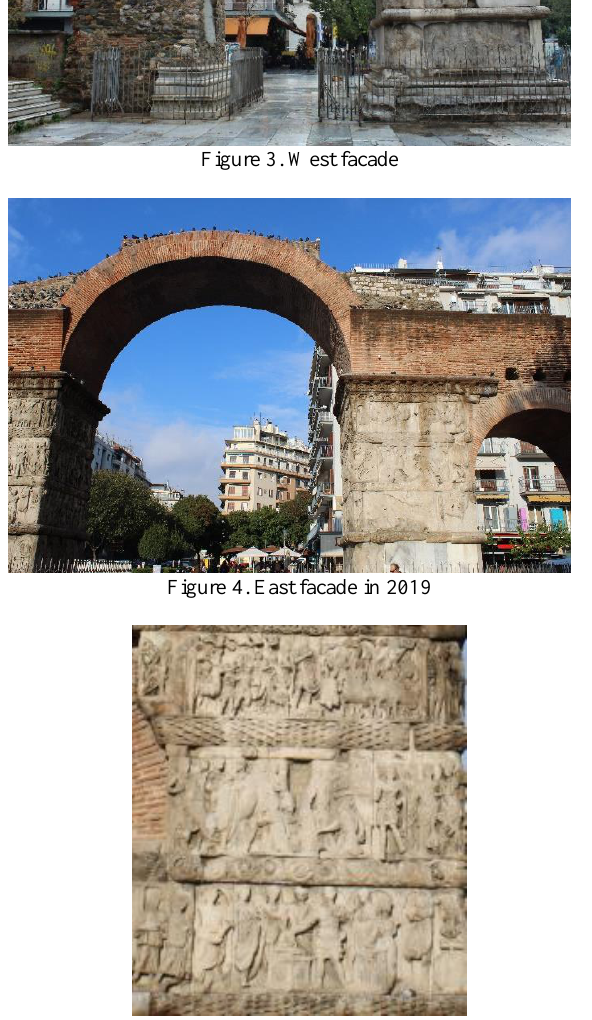
Figure 5. Embossed scenes in the Arch of Galerius